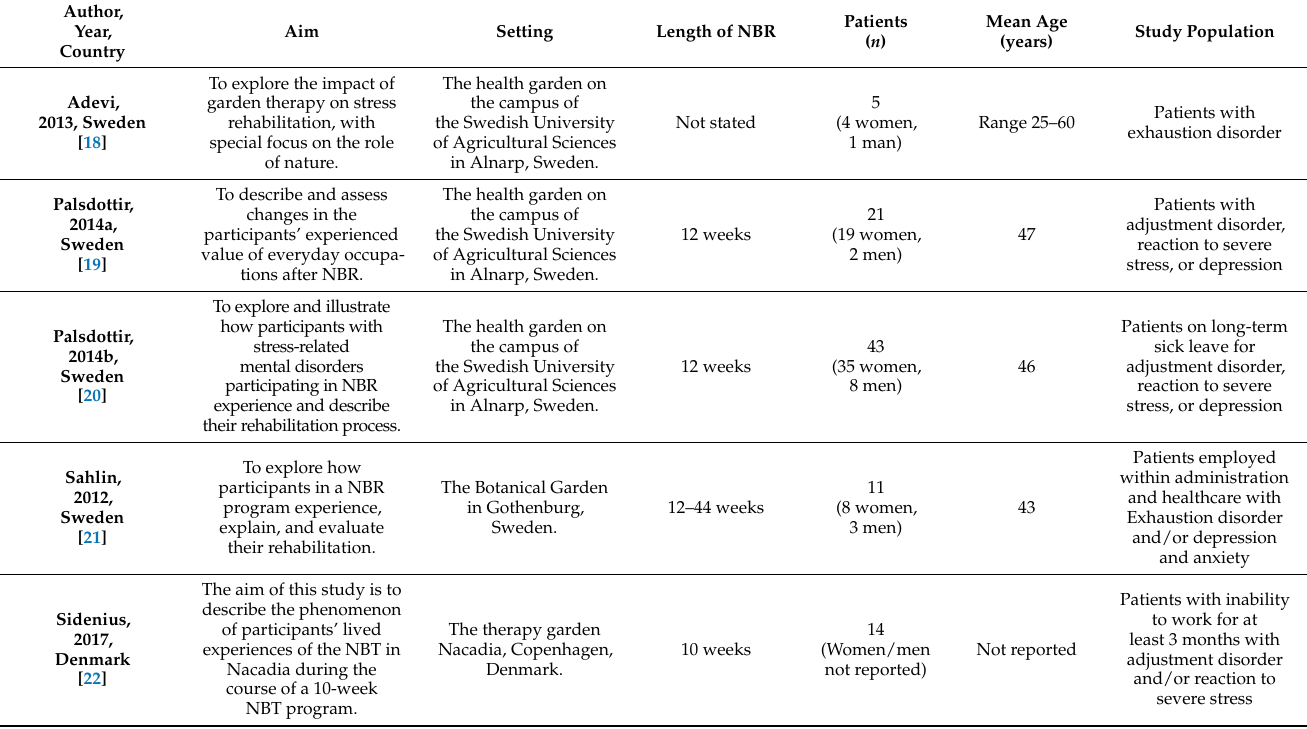
Figure 1. Flow diagram of the selection process (modified from Moher et al., 2009 [23].). Table 1. Characteristics of included